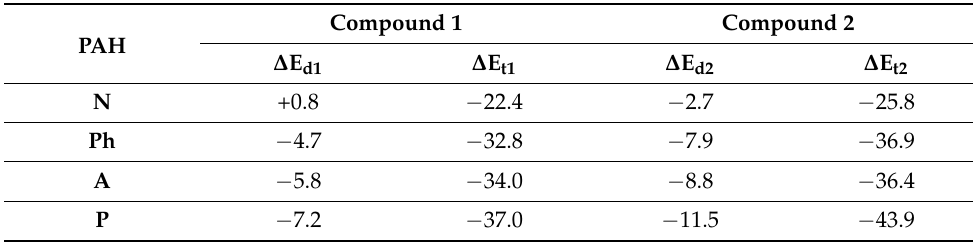
Table 3. Formation energies of the heterodimers ( ∆ E d1 and ∆ E d2 ) and heterotrimers ( ∆ E t1 and ∆ E t2 ) in kcal/mol for hosts 1 and